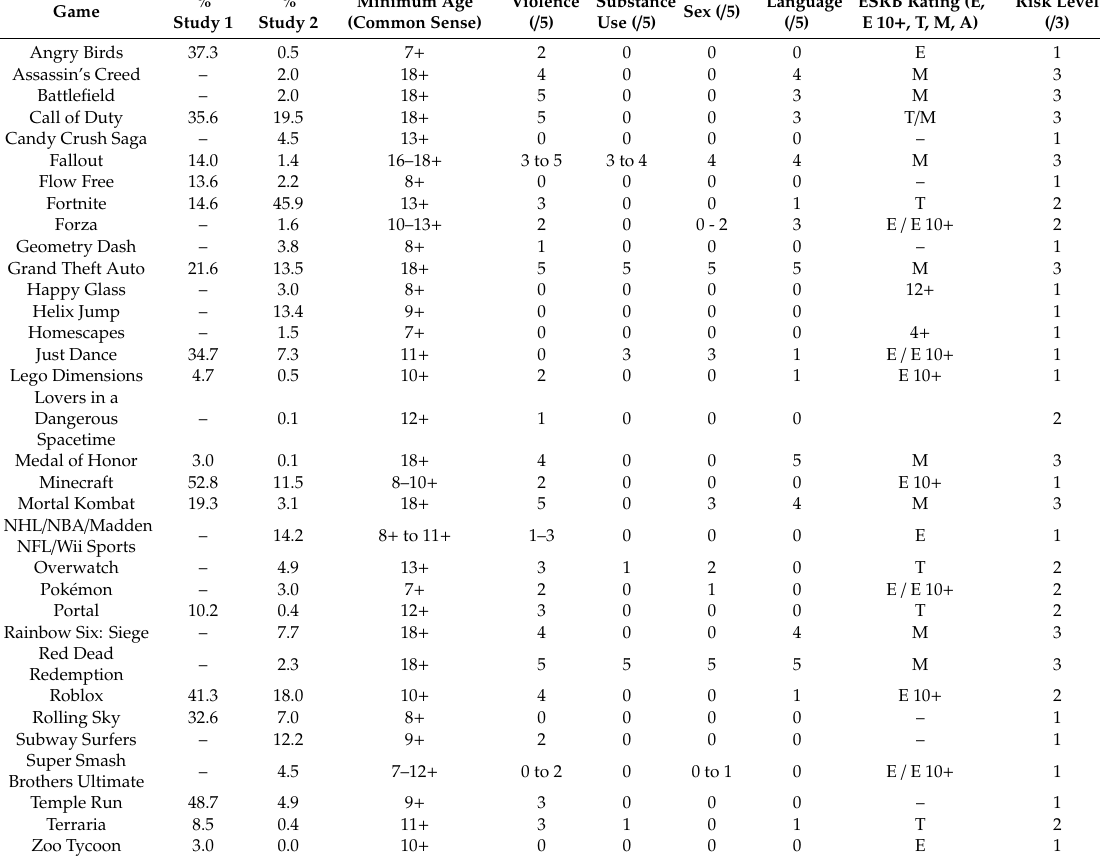
Table A1. Games Played by Participants in Study 1 and 2, Percent Played, and Risk